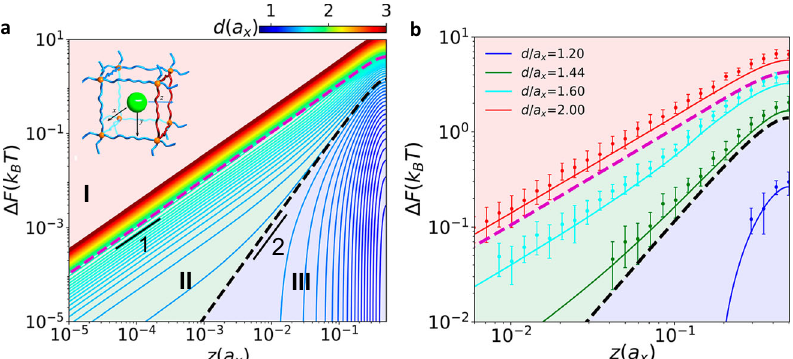
Fig. 2 Distinct scaling regimes of free energy change. a Dependence of Δ F ( z ) on the position z for various d in the log-log scale, obtained from the theoretical model of a network-particle system with g = 6. The upper left inset shows the axes of the system, where z axis is along the mean energy path (MEP). The dashed lines represent the theoretical boundaries separating different regimes. b The comparison between MC (points) and theoretical results (lines) for some representative particle sizes. The error bar indicates the standard deviation.